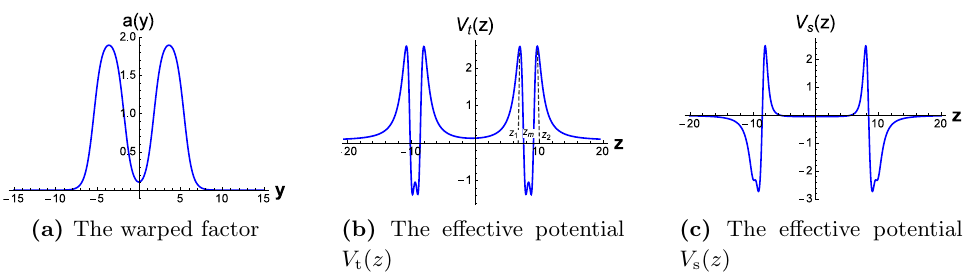
Figure 4. The warped factor a ( y ) and the e(cid:11)ective potentials V t ( z ) and V s ( z ) for the double brane model (3.5). The parameters are set to k = 1, and b = 1 : 8.